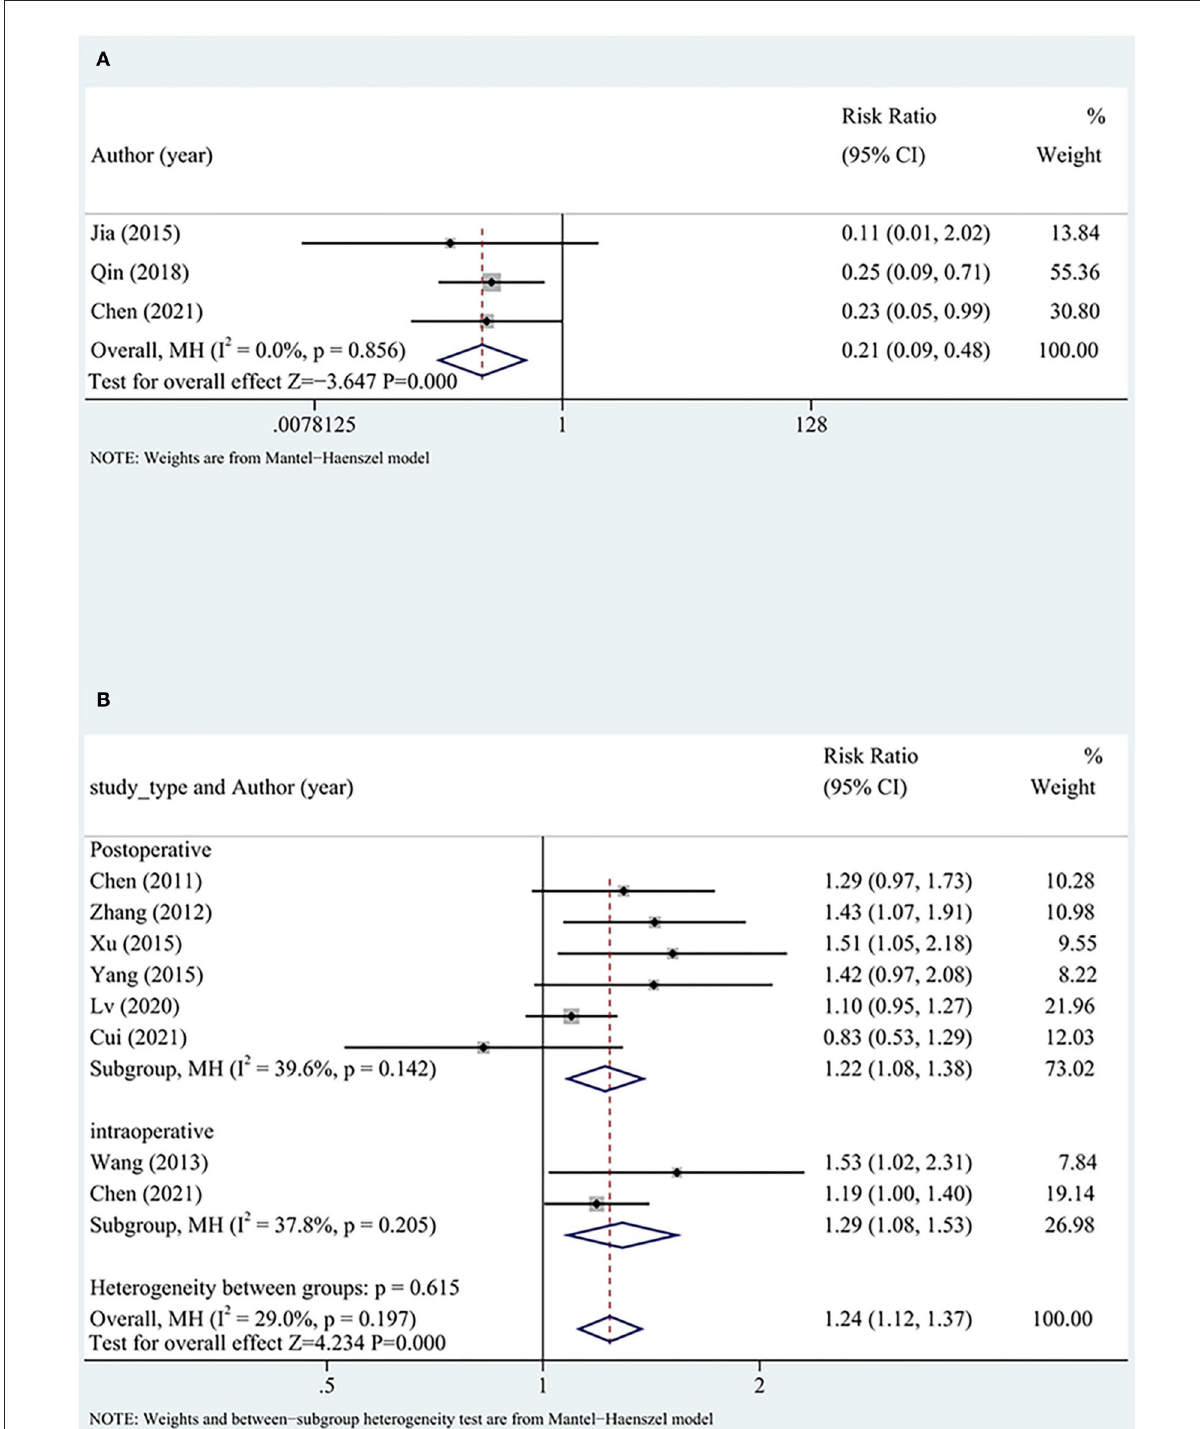
FIGURE4 Reperfusion subgroup analysis including (A) TIMI flow grade and (B) STR. TIMI, thrombolysis in myocardial infarction; STR, ST segment